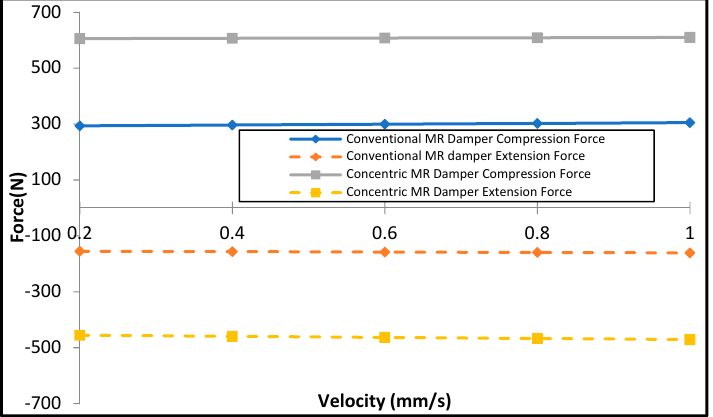
Figure 12. Damping comparison between conventional and concentric MR dampers at 0.3 A.